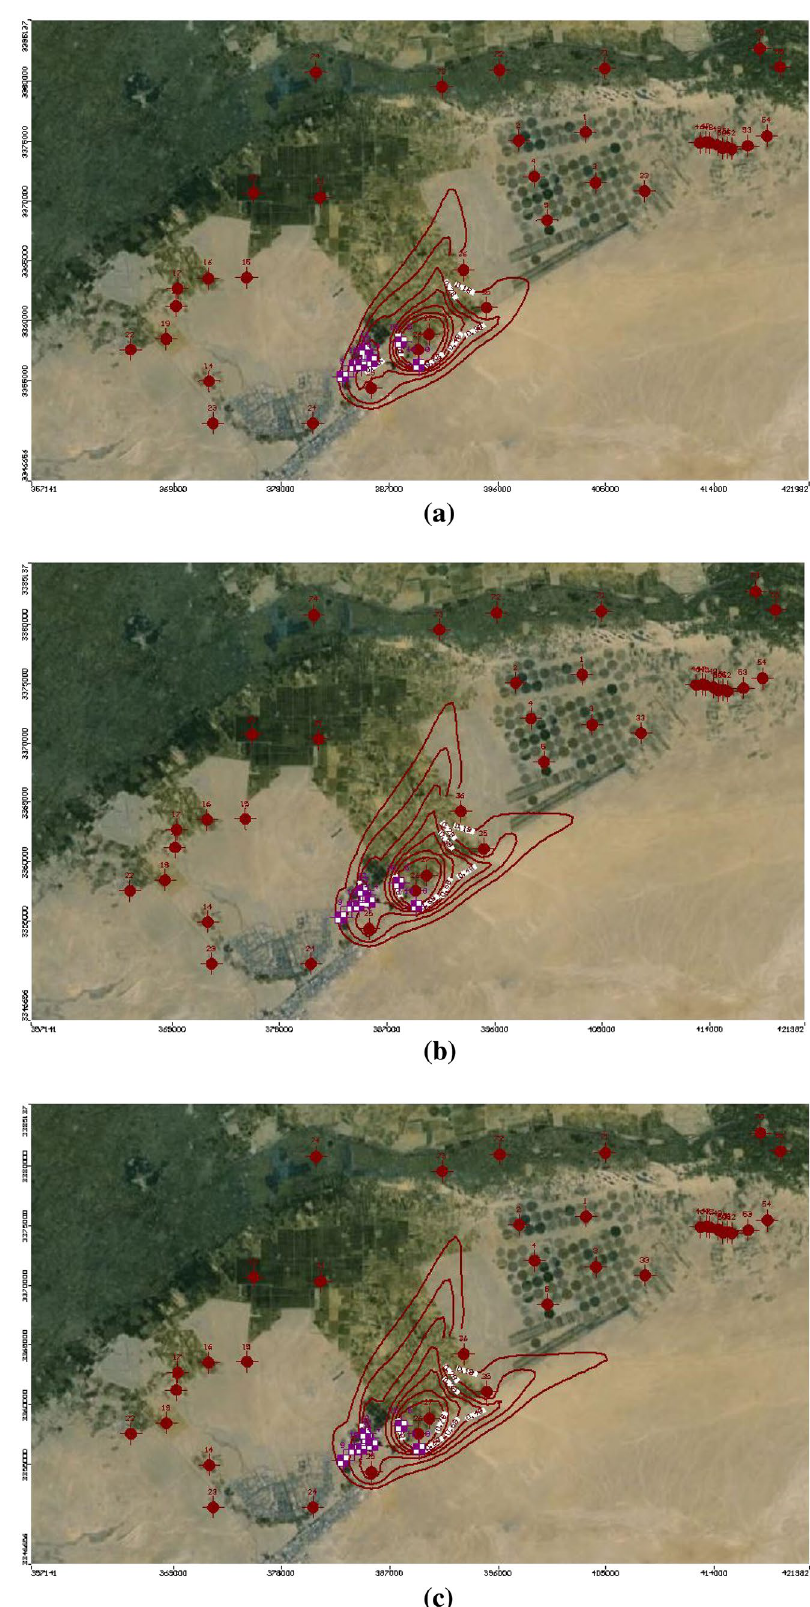
Fig. 12 Fe pollutant transport a after 10 years, b after 20 years, and c after 30